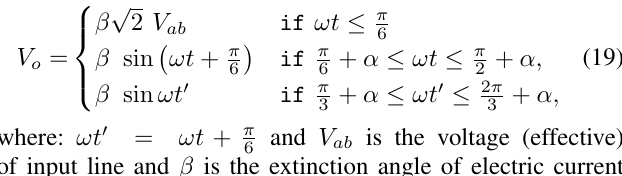
Figure 10. Case study